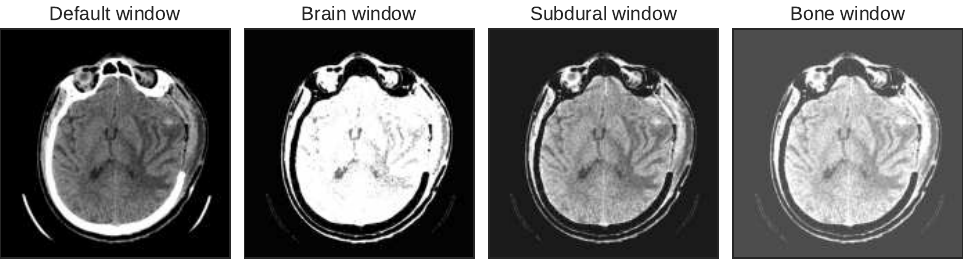
Figure 4. Representation of three intensity